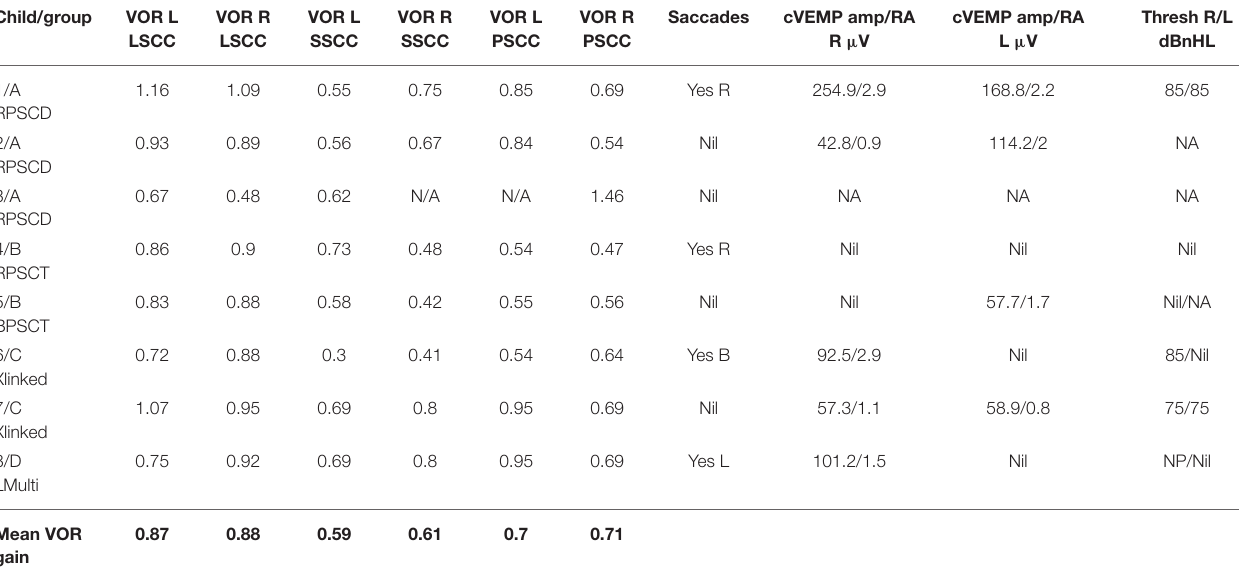
TABLE 5 | Children in case group, vHIT and cVEMP